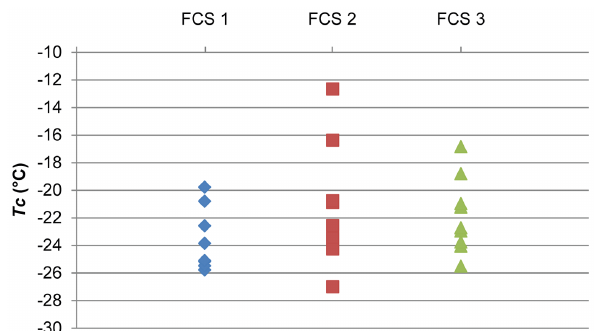
Figure 3. Diagram of the T c values obtained with the cryopreservation solutions containing FCS. FCS: foetal calf serum.